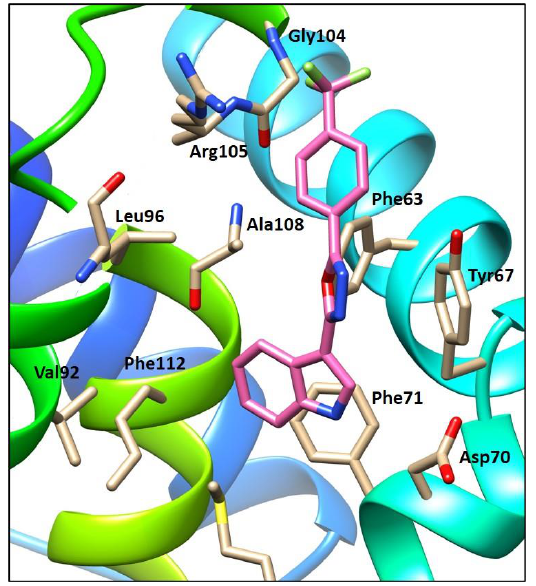
Figure 3. Compound 4j showed hydrophobic interactions with key residues Tyr67, Phe71, Leu96 and Ala108, in addition to a p-cation interaction between the trifluorophenyl group and the key residue Arg105.